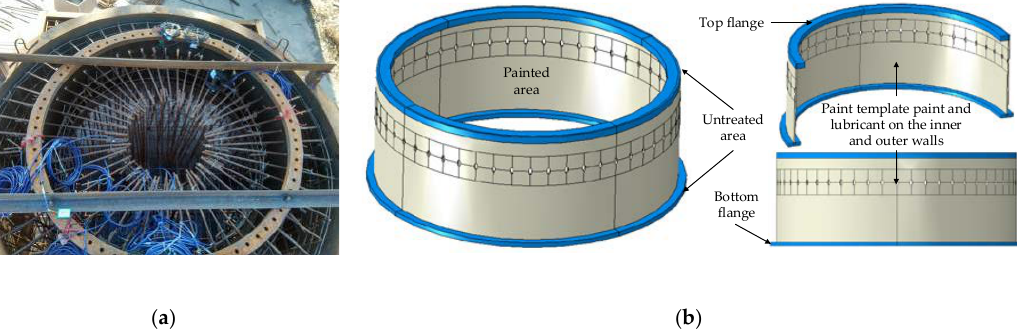
( b ) Figure 6. Loading system for indoor torque T. ( a ) Torque load loading mechanism for indoor torque T ( b ) Field loading experiment. In Figure 6, T on the foundation ring can be calculated as 𝑇𝑇 = 2 × 𝐹𝐹 1 ×